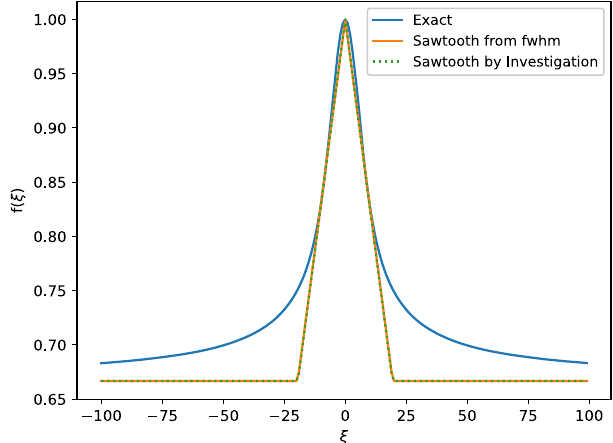
FIG. 1. FM prescription as a function of ξ . This plot compares three different FM functions: the optimal chirping solution [11], a sawtooth chirping function with a slope calculated from full width half max to peak, and the optimal sawtooth chirping function found by investigating spectral peak increase with varying slope values. The chirping prescription using slope between FWHM and the peak provides the optimal spectral peak